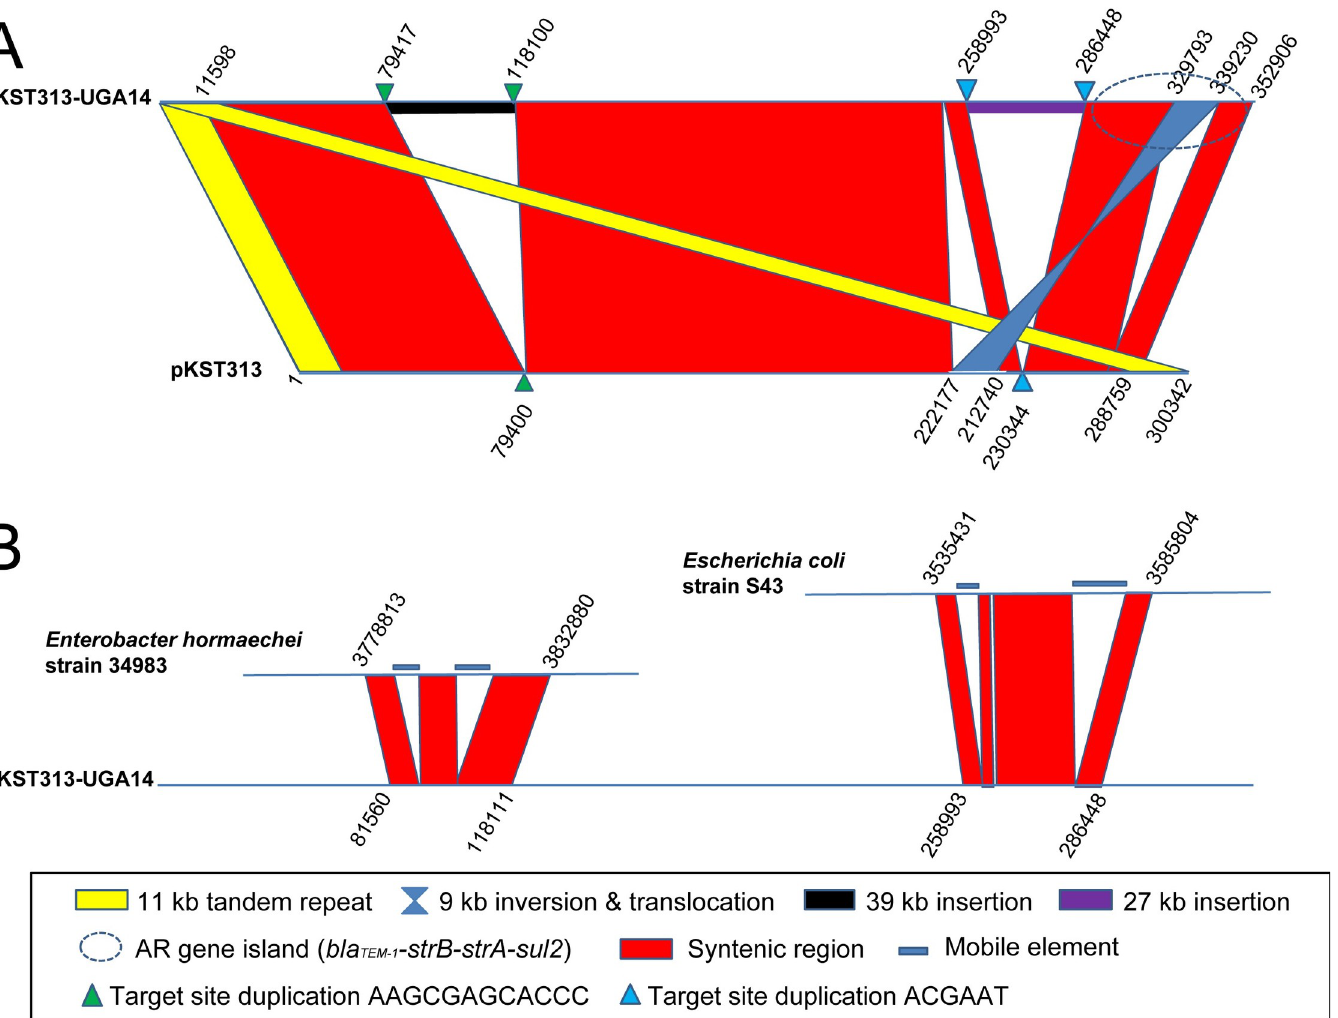
Fig 3. Plasmid synteny between S . Typhimurium UGA14 plasmid pKST313-UGA14 and reference plasmids. Comparisons were made using the Artemis Comparison Tool (ACT) [62]. (A) pKST313-UGA14 compared to reference plasmid pKST313 [21] with regions of homology indicated in red or blue (inversion), an AMR gene island indicated with a blue circle (dashed line), direct repeats in pKST313 highlighted in yellow, and loci of insertion and its target site duplication labeled with triangles. (B) Two inserted regions of pKST313-UGA14 are compared with potential donor organisms, Enterobacter hormaechei strain 34983 and Escherichia coli strain